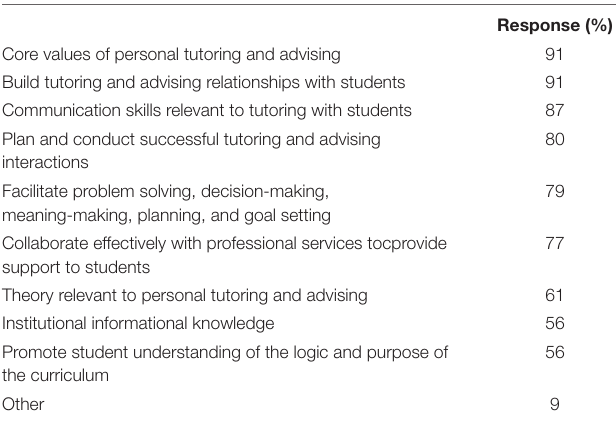
TABLE 3 | Responses to the question “Which specific skills, competencies and behaviors do you think should be included in any standards for personal tutoring and academic advising?” Which Specific Skills, Competencies and Behaviors Do You Think Should Be Included in Any Standards for Personal Tutoring and Academic Advising? Please Select All Which